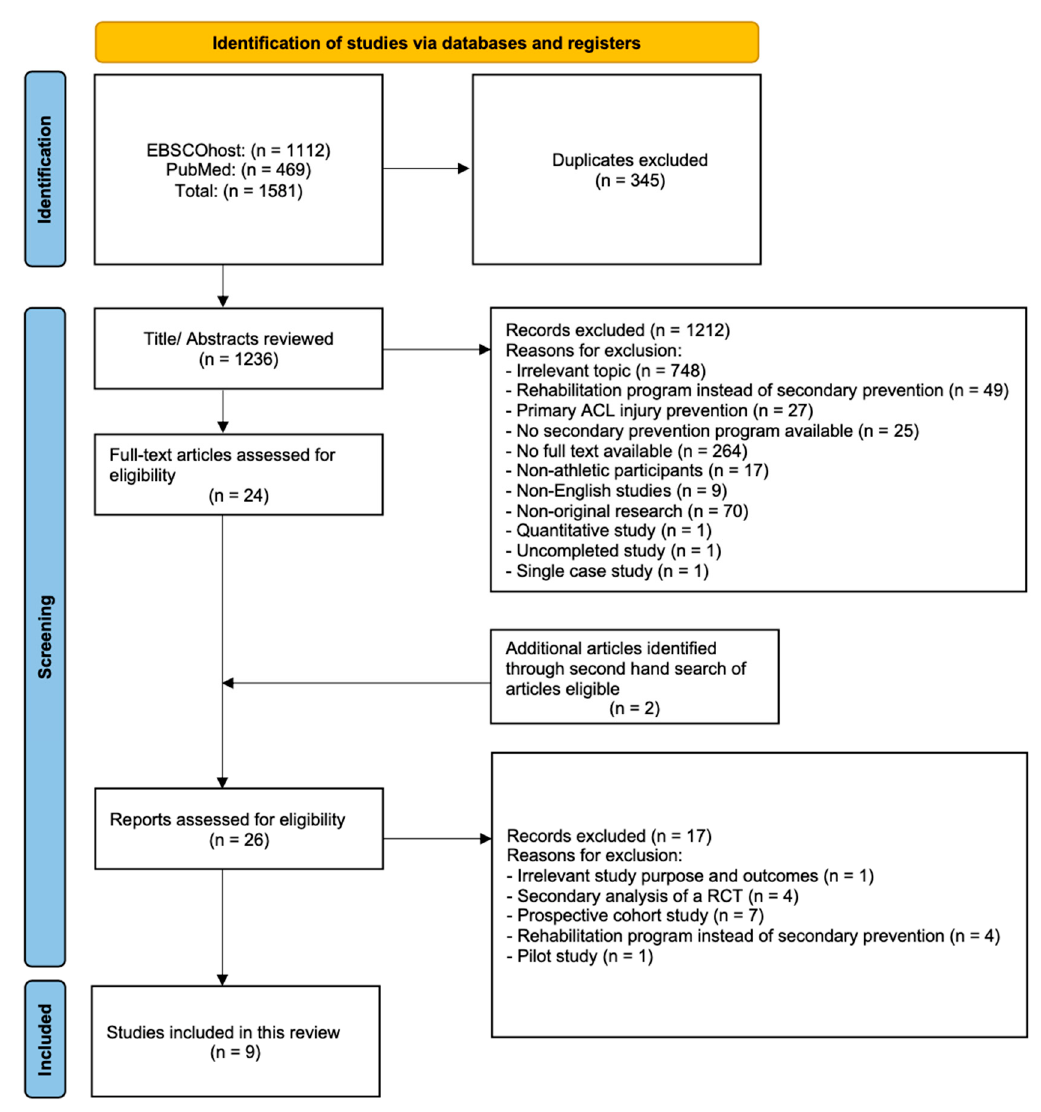
Figure 1. Flow of information through the systematic literature search and screening.